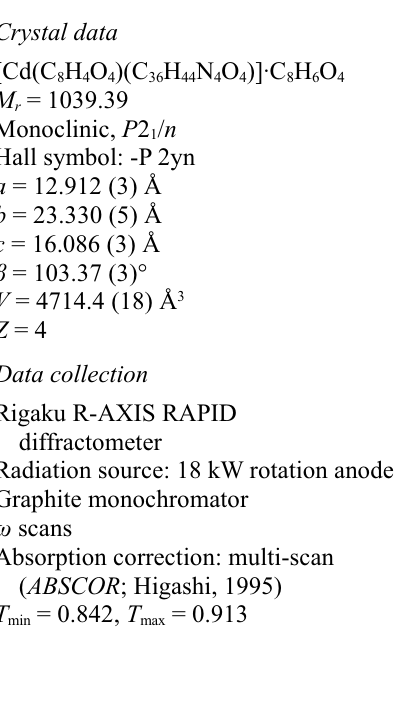
Figure 2 View of the two-dimensional supramolecular structure of the title compound. Hydrogen bonds are shown as dashed lines. (Benzene-1,3-dicarboxylato- κ 2 O 1 , O 1 ′ )(1,12,15,26-tetraaza- 5,8,19,22-tetraoxa-3,4:9,10:17,18:23,24- tetrabenzocyclooctacosane- κ 4 N 1 , N 12 , N 15 , N 26 )cadmium(II) benzene-1,3-dicarboxylic acid